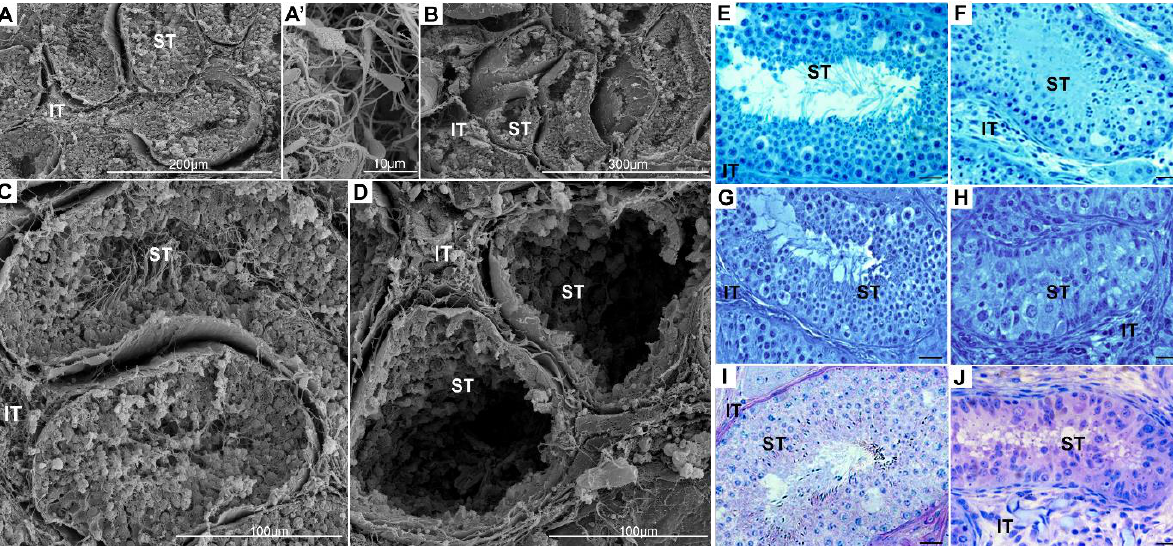
Figure 1. The general structure of healthy ( A , A’ , C , E , G , I ) and cryptorchid ( B , D , F , H , J ) horse testicular tissues, respectively, which were used for analysis via scanning electron microscopy. Bars represent 1 µm. Histochemical staining of healthy and cryptorchid horse testes for the presence and localization of total protein content by naphthol blue black (NBB) ( E , F ), acidic content by toluidine blue O (TBO) ( G , H ), and polysaccharide content by PAS ( I , J ). Bar 20 µm. Histochemical staining was performed on three serial sections from each subject’s testis. IT—interstitial tissue, ST—seminiferous tubules.